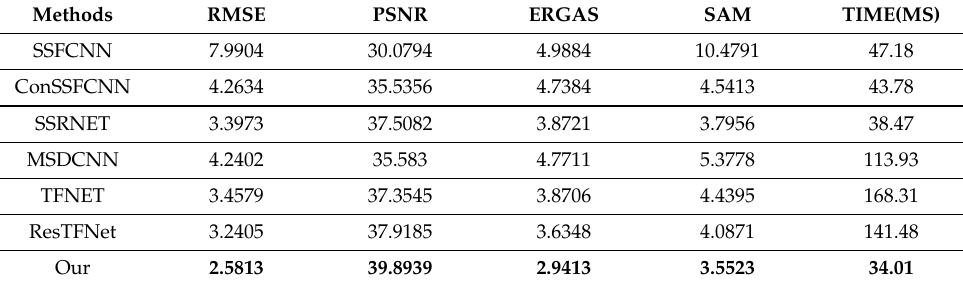
Table 5. Quantitative evaluation on the Pavia dataset (bold indicates the best results). Methods RMSE